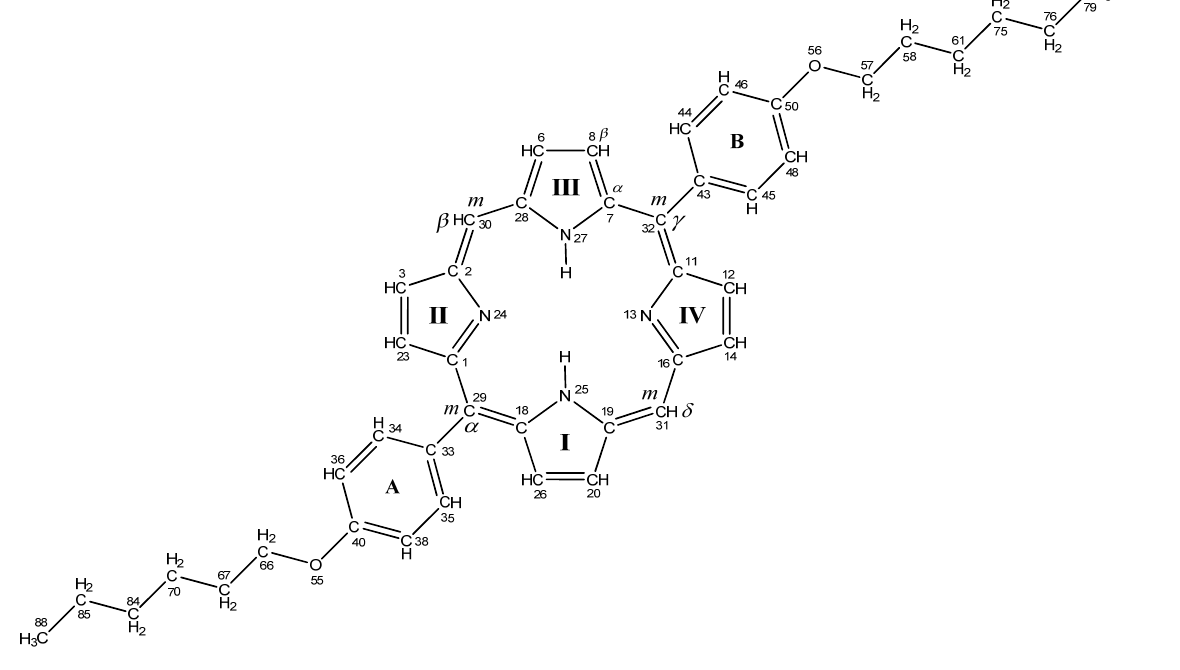
Figure 3. Labeling diagram of 10,20-bis(4-hexoxyphenyl)-porphyrin in TD DFT calculations for FTIR analysis. m